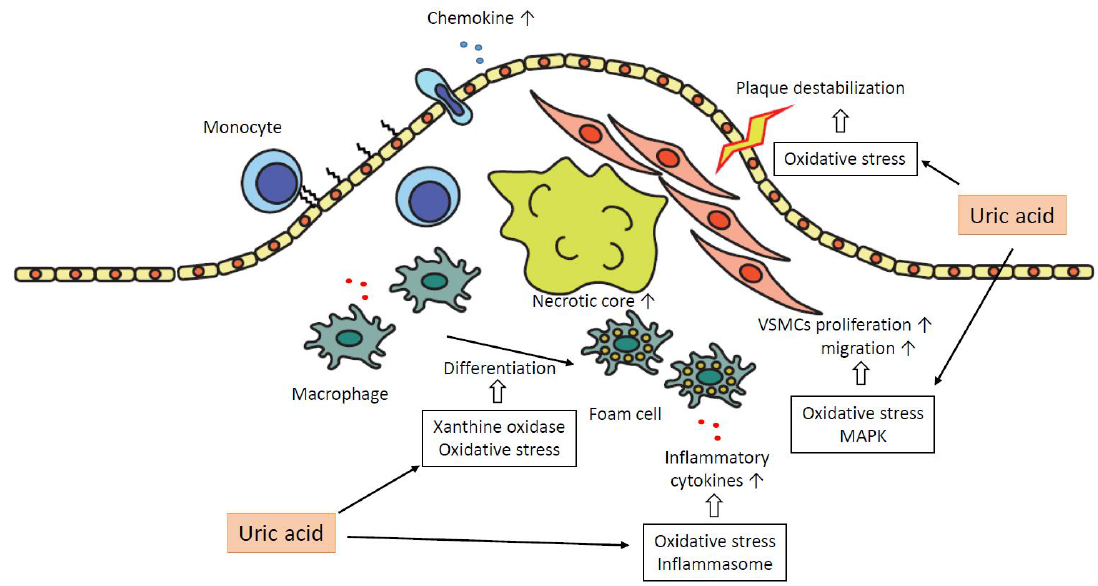
Figure 3. The role of uric acid in the formation of atheroma plaque. Uric acid plays a pro-atherogenic role in several steps in the progression of plaques. MAPK, mitogen-activated protein kinase; VSMCs, vascular smooth muscle cells.